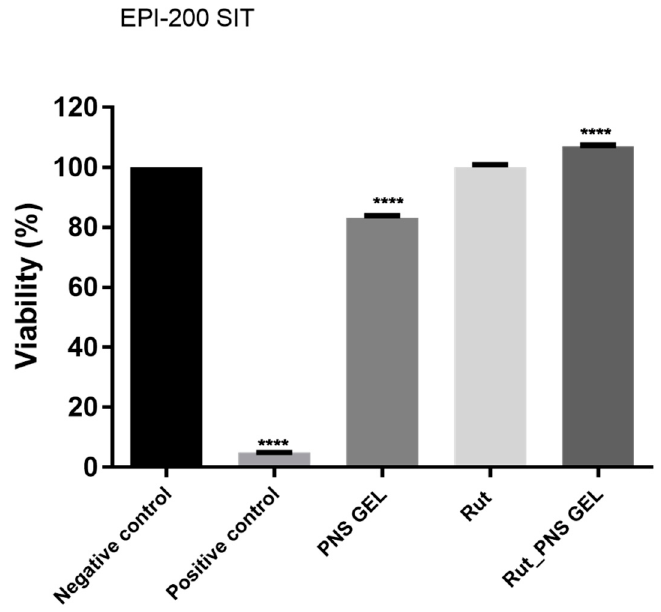
Figure 6. Viability percentage of EpiDerm skin model inserts (EPI-200 SIT) at 18 h posttreatment with the test samples (proniosomal control gel, rutin and proniosomal rutin gel). One-way analysis of variance (ANOVA) followed by Tukey’s post-test was employed to determine the statistical differences between sample-treated inserts and negative control-treated inserts ( p < 0.0001 indicated by ****). Positive control is represented by SDS 1%, and negative control is represented by DPBS.